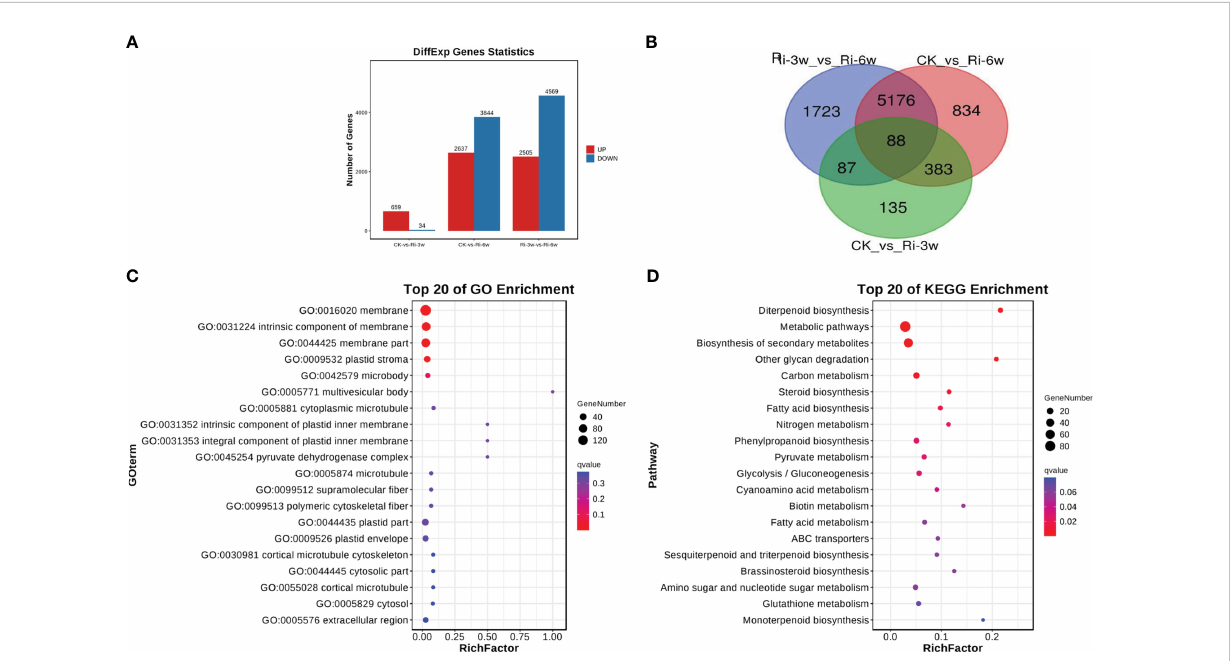
FIGURE 4 Differentially expressed genes (DEGs) and functional analyses. (A) Number of up- and down-regulated DEGs in pairwise comparison between groups. (B) Venn diagram showing the number of common DEGs shared by groups. (C, D) GO and KEGG annotation and enrichment analyses of DEGs between CK and Ri-3w, respectively.